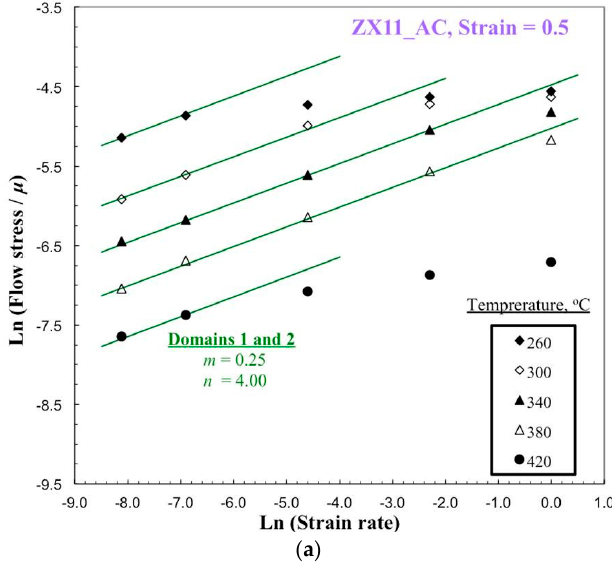
Figure 7. Microstructures of specimens deformed in ( a ) Domain 1 (300 °C/0.001 s − 1 ), and ( b ) Domain 2 (380 °C/0.01 s − 1 ). The compression axis is